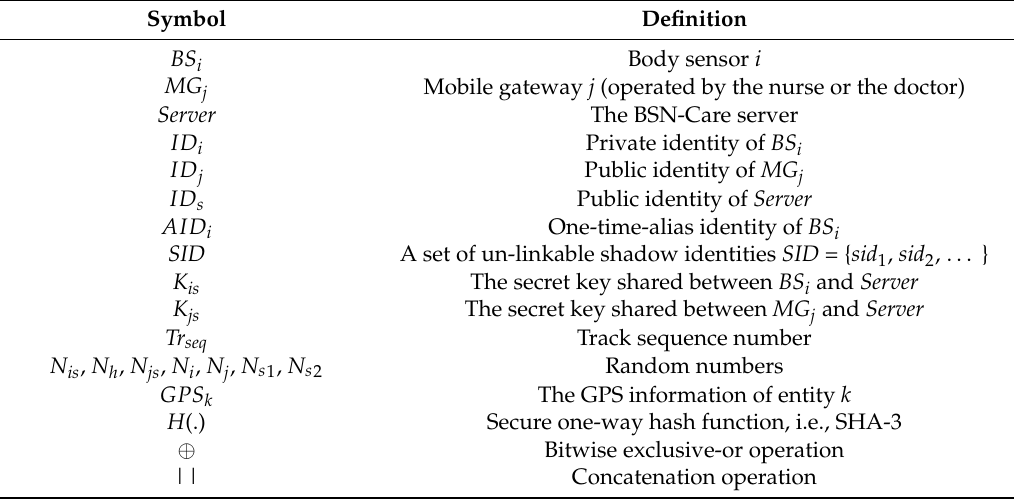
Table 1. Notations throughout the communication process of the